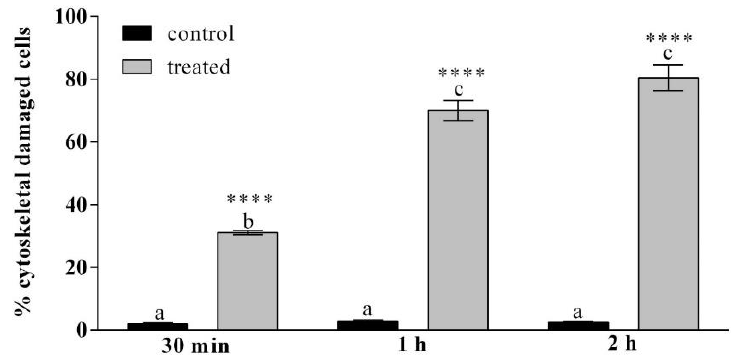
Figure 7. Percentage of haemocytes stained with phalloidin showing cytoskeletal damage, after treatment with OPs deriving from 2 equivalent females at different times of exposure (30 min, 1 h and 2 h). Data are presented as mean ± SD ( n = 3). Statistical analysis was performed with one-way ANOVA and Bonferroni (for control vs. treatment analysis) and Tukey post-hoc test (for all sample analysis). Different letters indicate significant differences among all treatments ( p value < 0.0001), asterisks indicate significant differences between control and treated samples at the same experimental time ( p value < 0.0001).